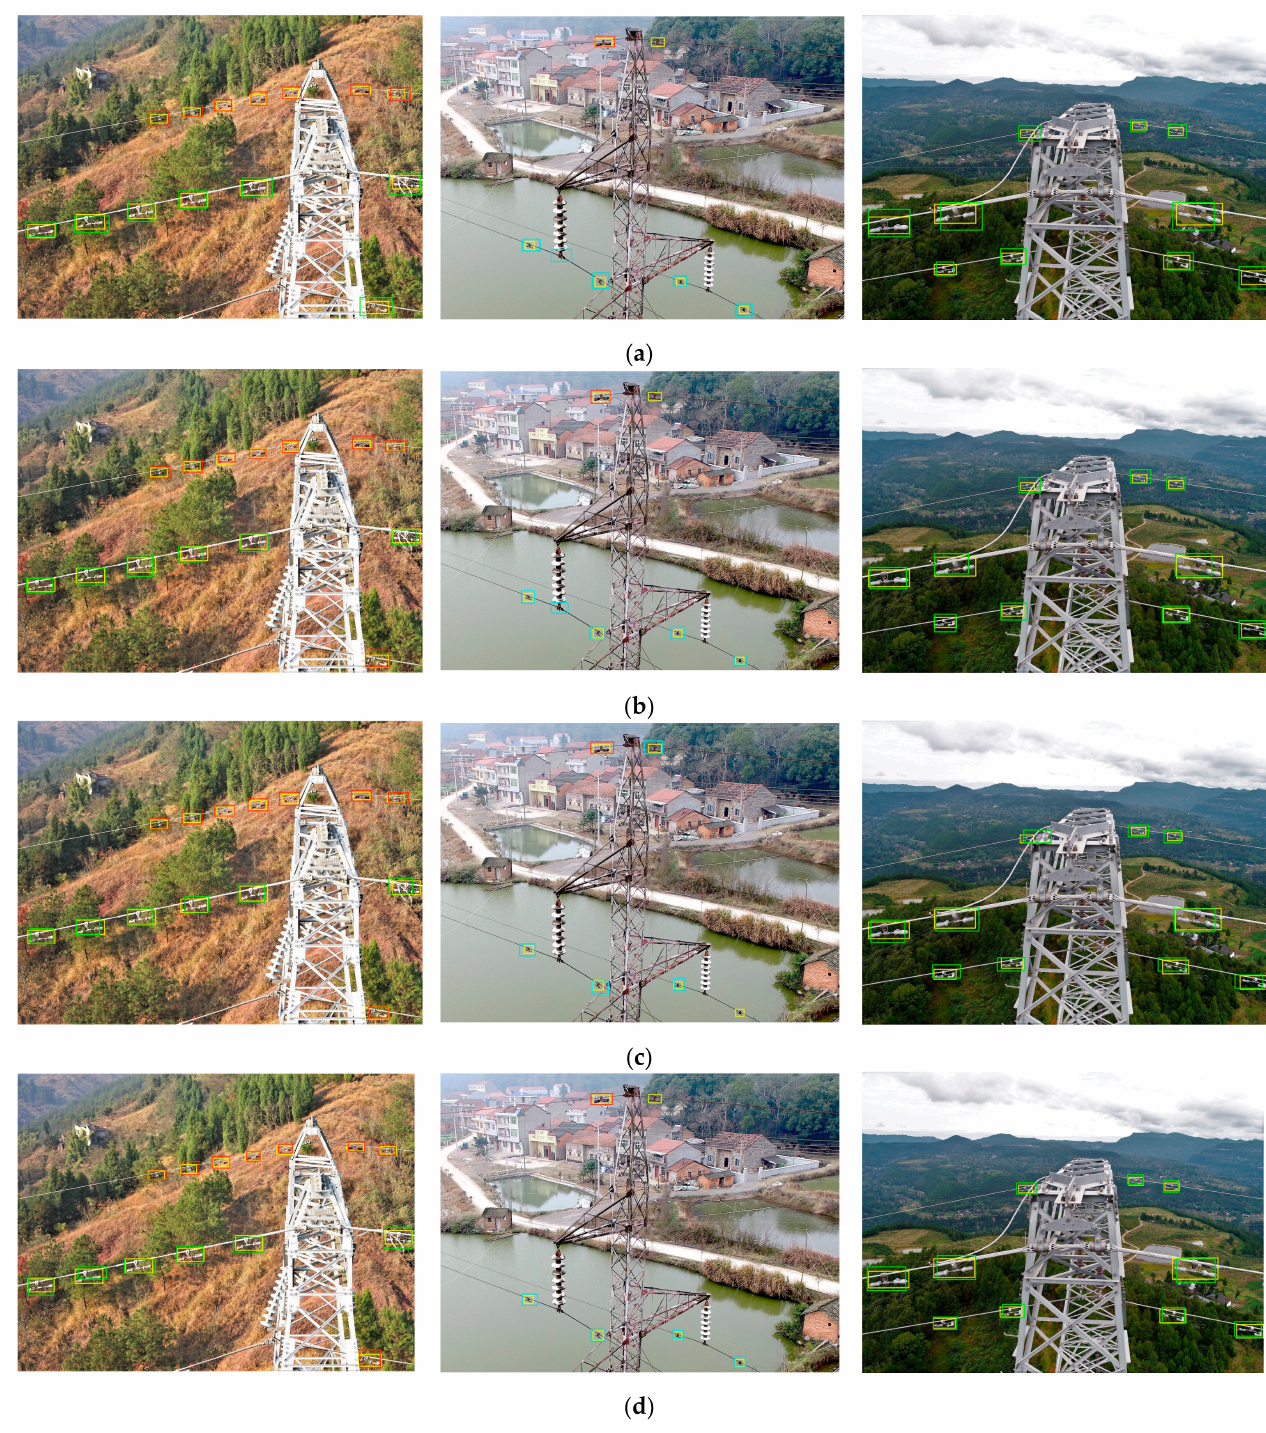
Figure 18. Visualization of the test results from combining different attention modules with YOLOv4: ( a ) YOLOv4; ( b ) YOLOv4 + SE; ( c ) YOLOv4 + CBAM; ( d ) YOLOv4 + PMA. The ground truth boxes and prediction boxes for “rusty”, “defective”, and “normal” dampers are shown in yellow, red, blue, and green,